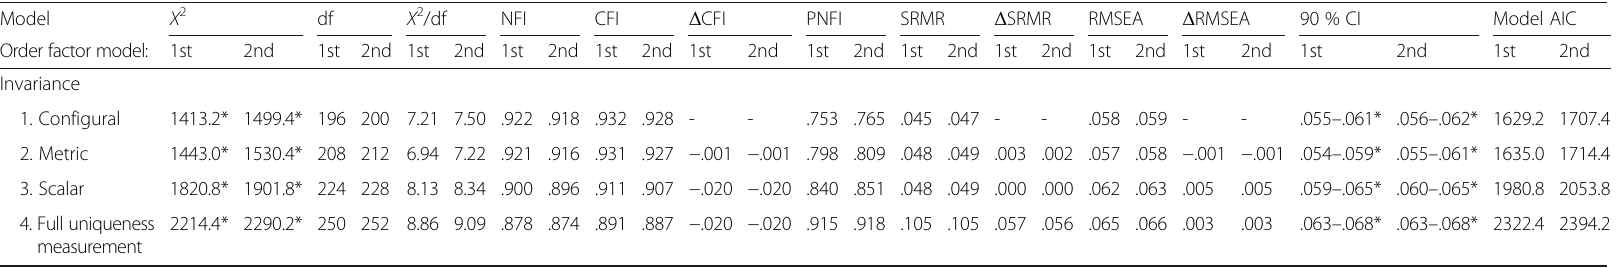
Table 4 Fit statistics for measurement of invariance for first-order and second-order factor models ( N = 1861)